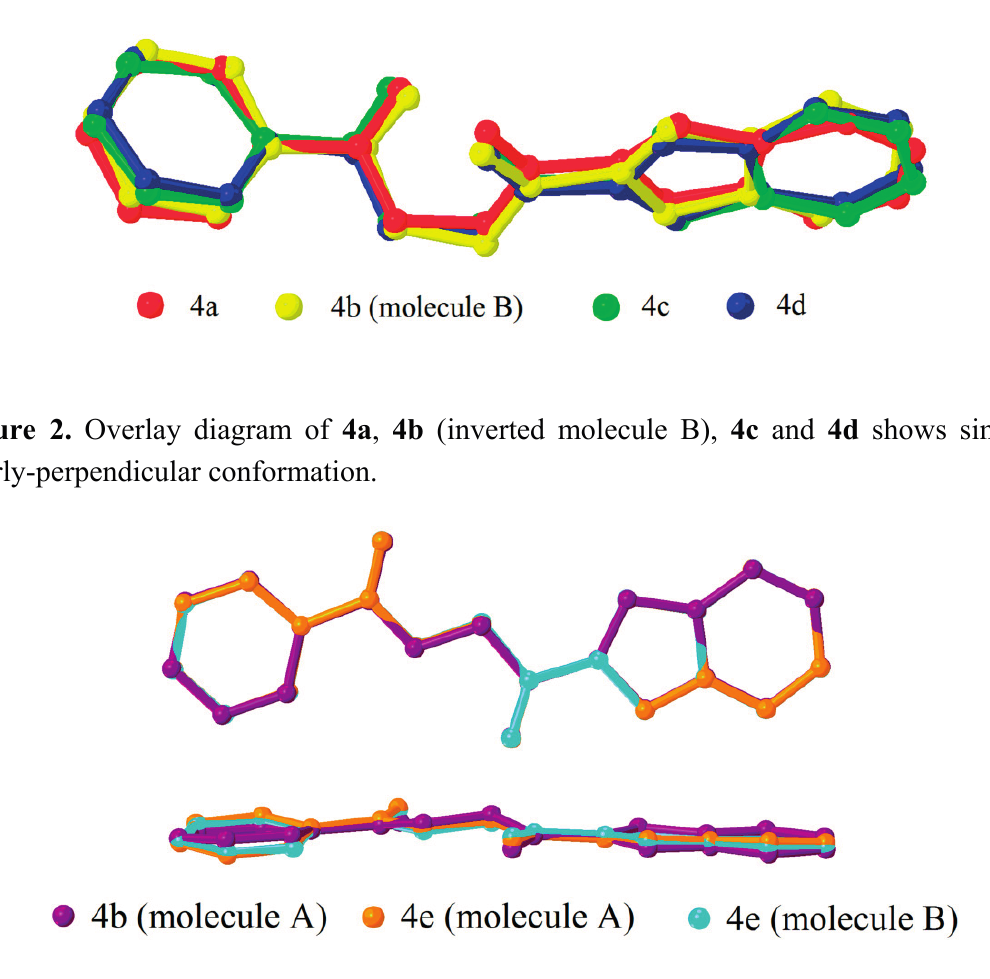
Figure 3. Overlay diagram of nearly flat conformer, 4b (molecule A), 4e (molecules A and B), viewed (up) perpendicular to or (down) along the mean